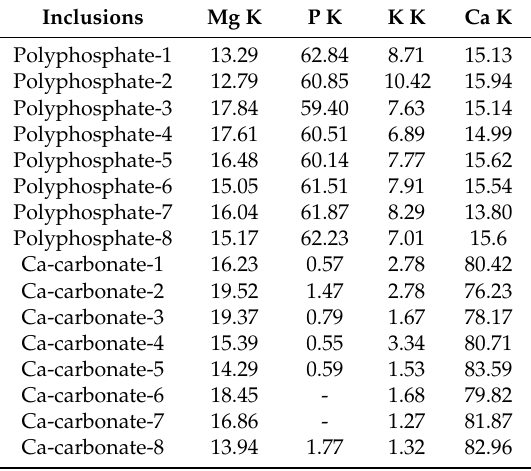
Table A1. Atomic ratios of Mg-P-K-Ca within polyphosphate and carbonate inclusions formed by Ca . G. lithophora C7 grown in BG-11 medium for two